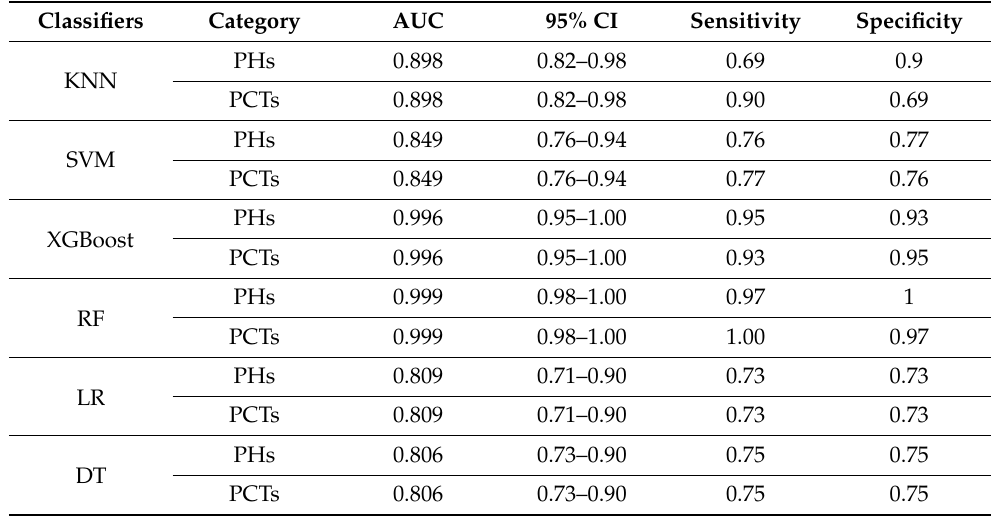
Table 2. ROC outcomes with six machine learning classifiers for the test set using the first